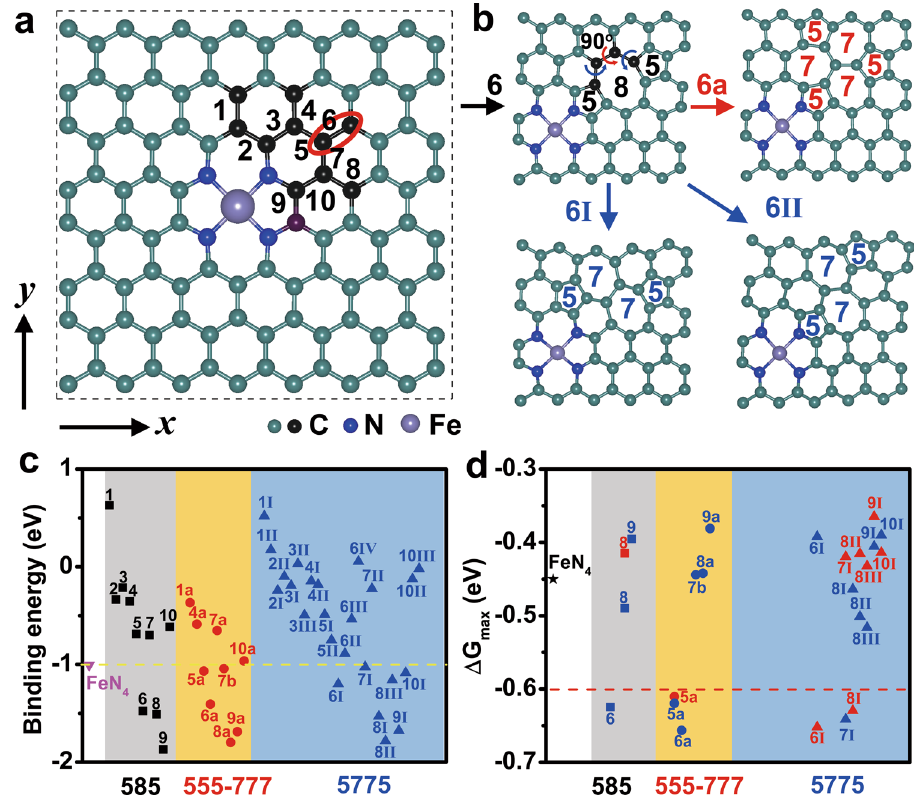
Fig. 1 Modeling and performance evaluation of single-atom Fe-N 4 sites. a Optimized structure of a perfect FeN 4 site. b Divacancy defect models 6, 6a, 6I, and 6II. c The binding energy of Fe site. d The ORR activity of Fe-N 4 sites. Blue and red represent upper and lower surface activity, respectively.